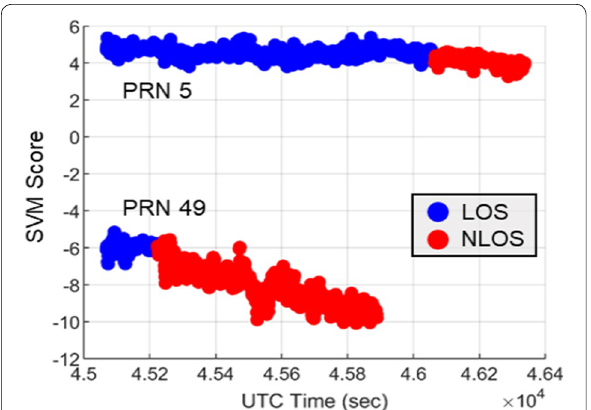
Fig. 12 Demonstration of SVM score of misclassified satellite